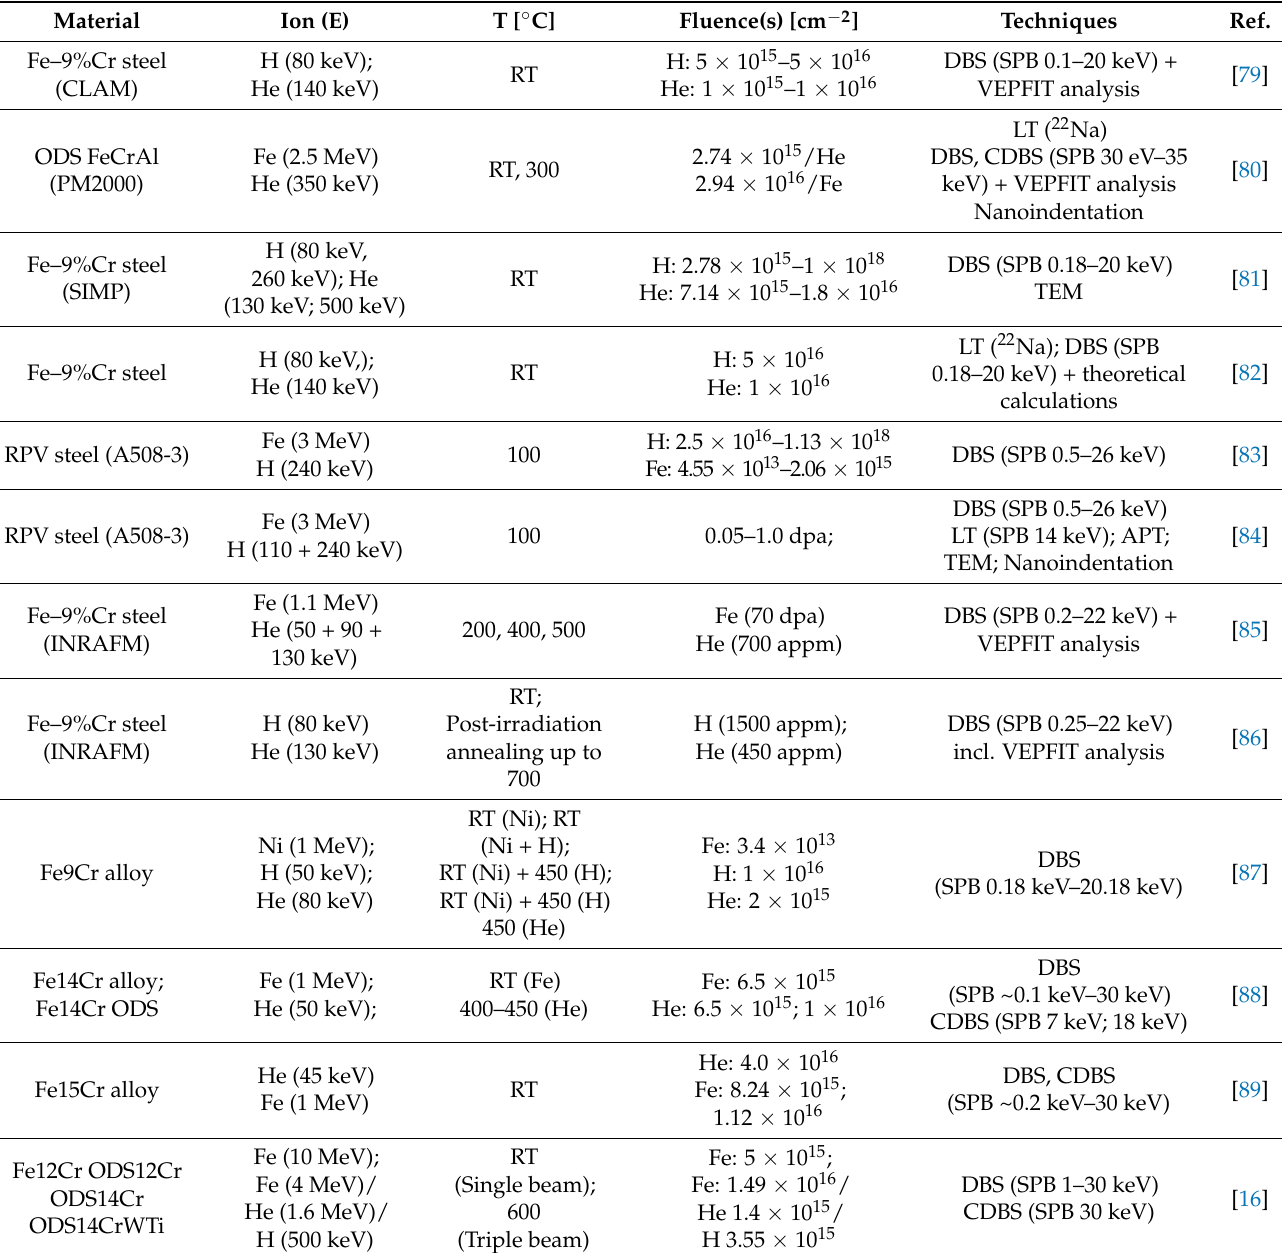
Table 4. Selected PAS studies published on synergistic effects of heavy-ion and H/He irradiation on the microstructure of nuclear structural